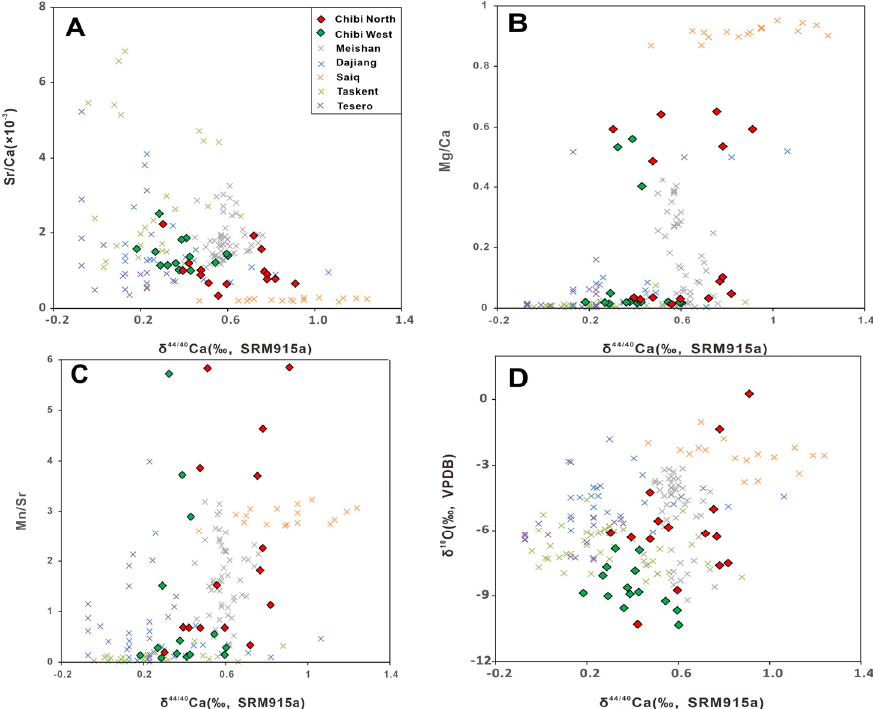
Figure 4. Scatter plots( A ) Ca/Sr vs. δ 44/40 Ca; ( B ) Mg/Ca vs. δ 44/40 Ca; ( C ) Mn/Sr vs. δ 44/40 Ca; ( D ) δ 18 O vs. δ 44/40 Ca.Reflecting the impact of the diagenesis. Filled colored squares indicate data from this study. Colored forks indicate data from other profiles (Saiq, Tesero, Taskent data are from [5], Dajiang section are data from [14], and Meishan section data are from [22]) The data conversions for calcium isotopes are based on ( δ 44/40 Ca 915a = δ 44/40 Ca sw + 1.86‰, − 1.00‰) δ 44/40 Ca δ 44/40 Ca BSE = 915a